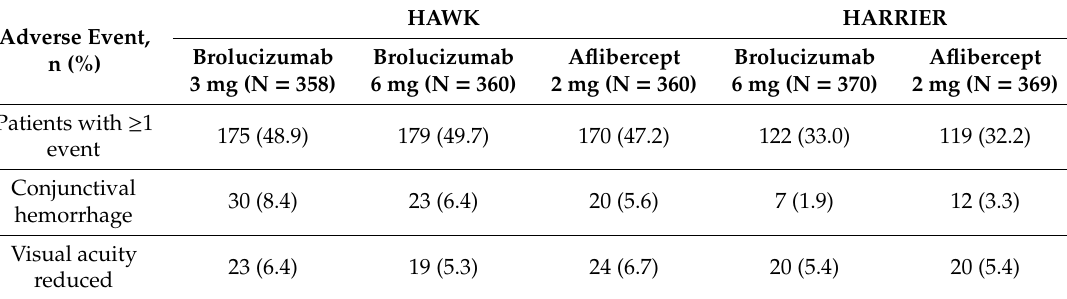
Table 7. Overview of the ocular adverse events (AE) reported by the HAWK and HARRIER in Study Eye. Adapted from Dugel et al.